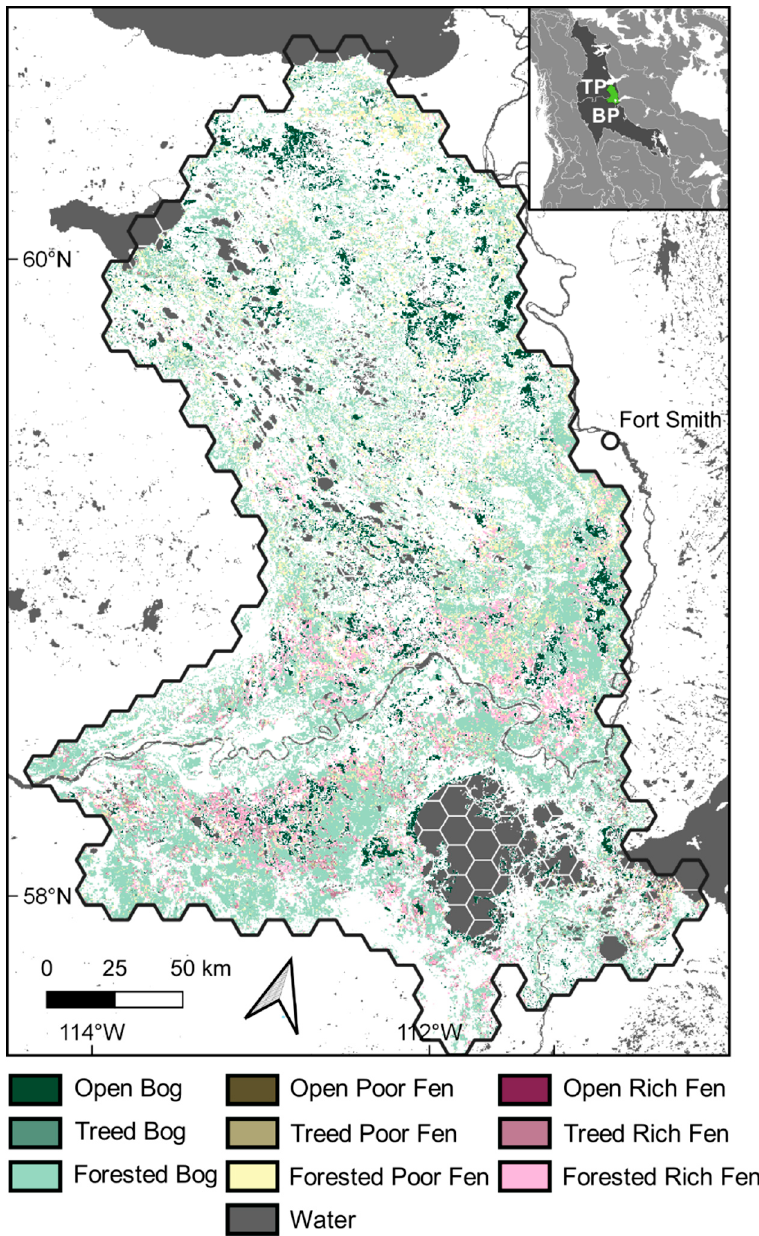
Figure 1. Study area and peatland cover. Inset map shows location of study area (green) within Taiga plains (TP) and Boreal plains (BP) North American Level II ecoregions [20]. The 10 kha hexagon grid is shown over water only.